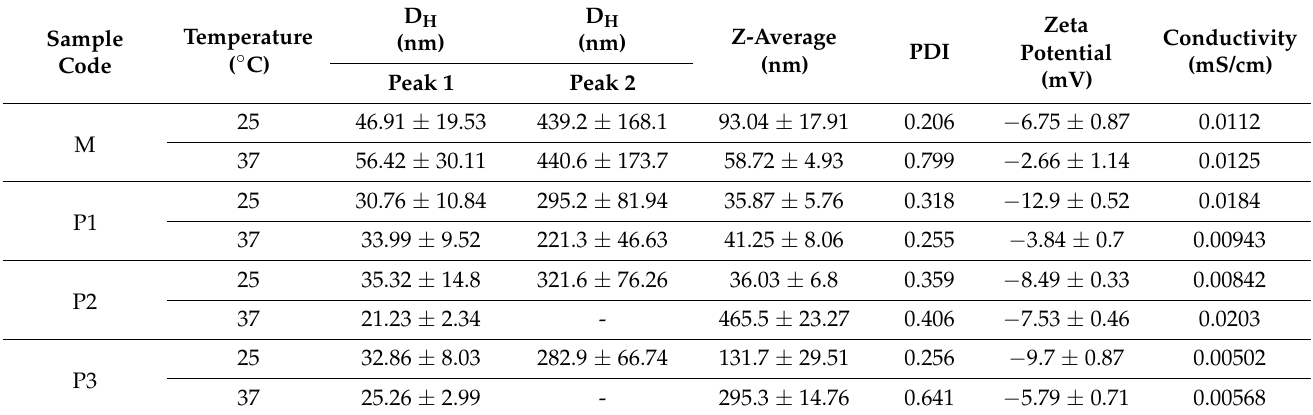
Table 1. DLS parameters characteristic to the polyurethane/peptide